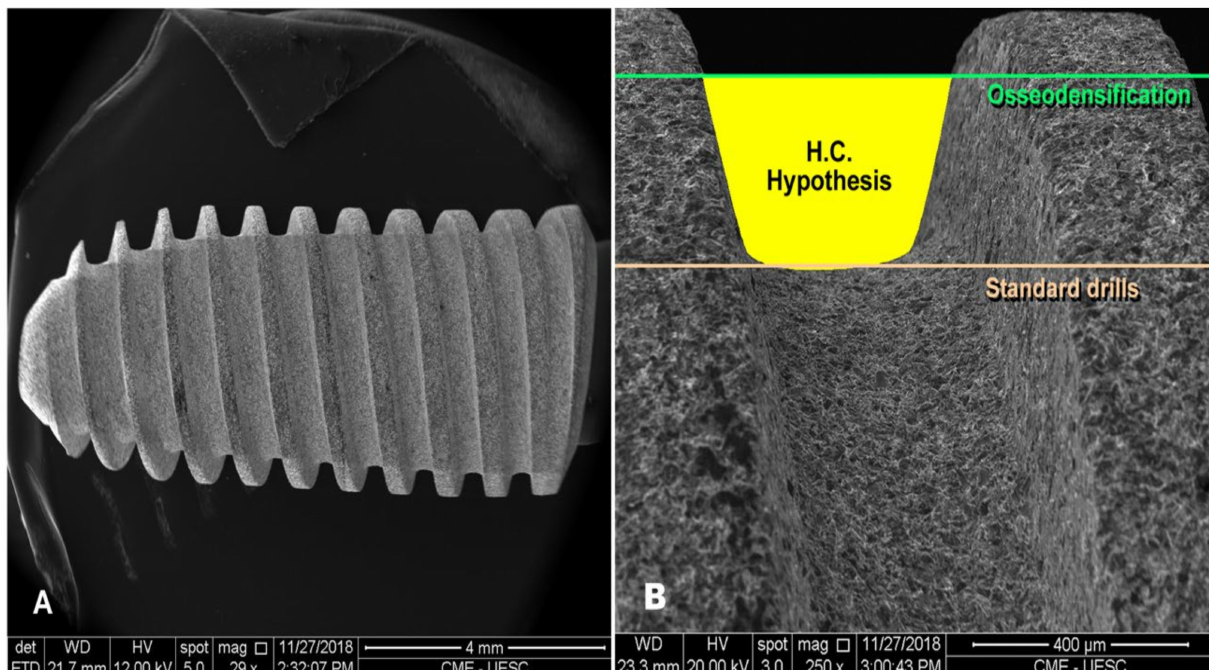
Figure 3. ( A ) Dental implant geometry and threads visualized using scanning electron microscopy (SEM) ( × 29) (Quanta 250, FEI Company, OR, USA); ( B ) SEM of the dental implant surface ( × 250)—space between the implant and bone interface exemplifying the “healing chamber” (H.C.) hypothesis with the wider implant bed preparation via